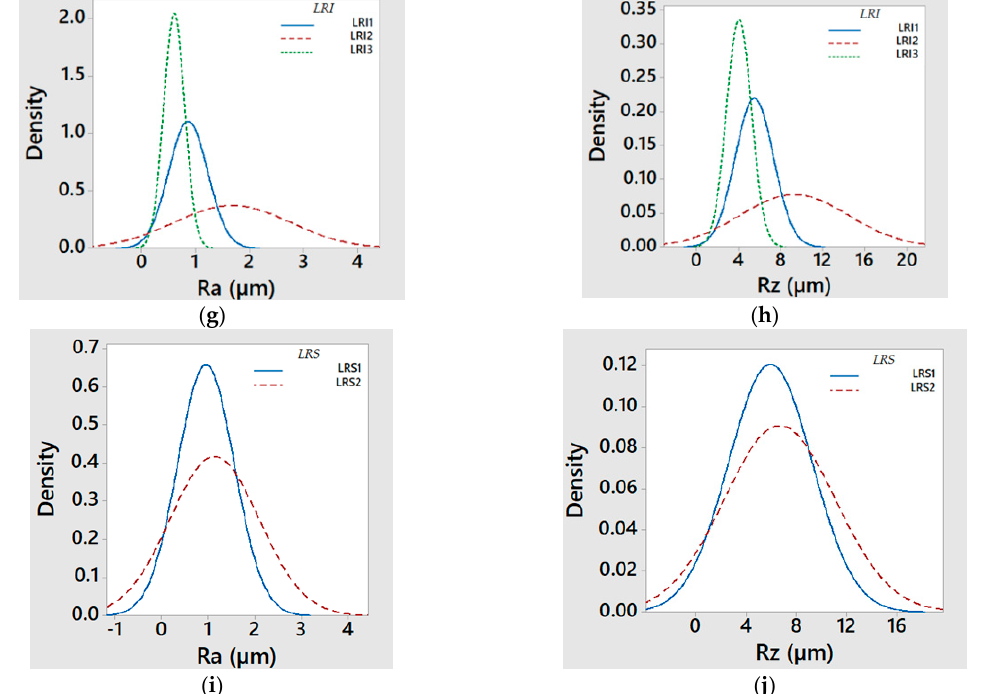
Figure 5. Normal distribution of Ra (µm) and Rz (µm), respectively, with respect to ( a ) and ( b ) feed rate, f (mm/rev); ( c ) and ( d ) spindle speed, N (rpm); ( e ) and ( f ) type of cooling system, C ; ( g ) and ( h ) location regarding insert, LRI; ( i ) and ( j ) location regarding specimen , LRS .